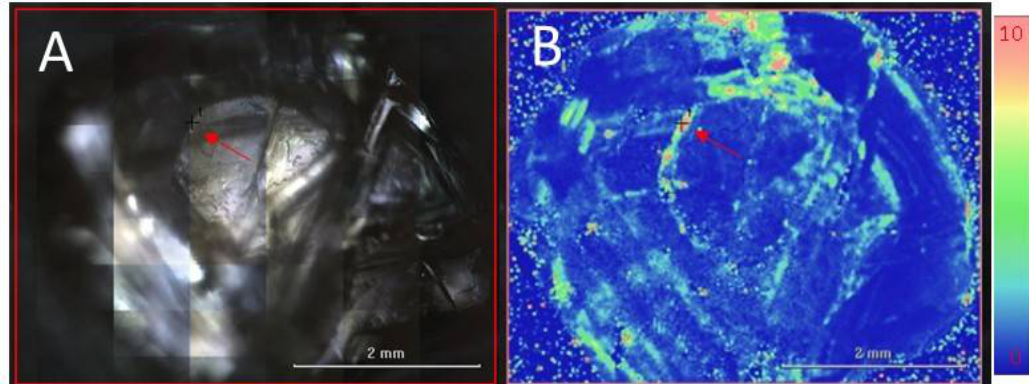
Figure 10. The 0.62 ct greenish rough diamond was termed the “Matryoshka” diamond because of the free-moving internal diamond. ( A ) Camera mosaic generated by the mapping instrument shows the internal diamond in focus and the external diamond out of focus; the confocal PL mapping was collected at the corresponding focal plane. ( B ) The PL map of the normalized GR1 defect intensity at 741.2 nm (normalized using the diamond Raman peak at 691 nm) was collected with 633 nm excitation at liquid nitrogen temperature. For this map, ~34,000 individual spectra were collected with a 25 µm pixel size over a collection time of 7½ min. The red arrow in both figures shows an area of high GR1 intensity on the surface of the internal diamond. For this diamond, we did not use graphite paint (e.g., Figure 2) as we were concerned about the paint potentially entering the internal cavity and instead fixed graphite tape to the bottom of the sample while imaging.